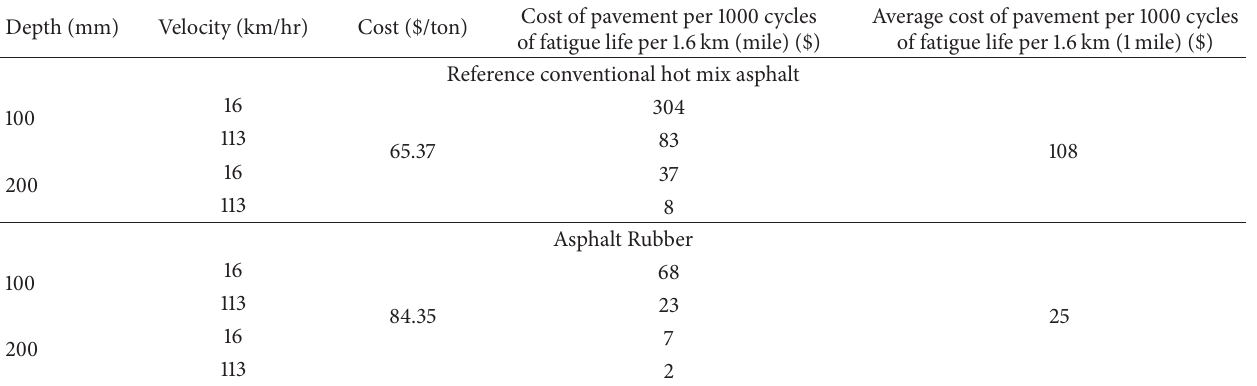
Table 3: Cost calculation per mile per 1000 cycles fatigue